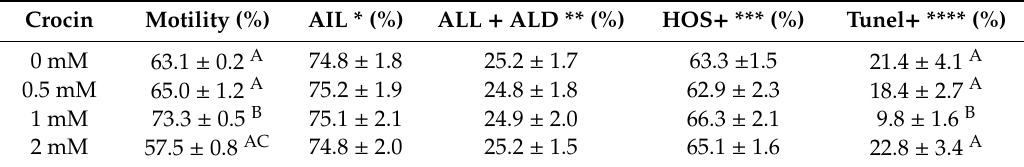
Table 1. E ff ect of di ff erent crocin concentrations on frozen-thawed semen qualitative characteristics. Data are expressed as mean values ±